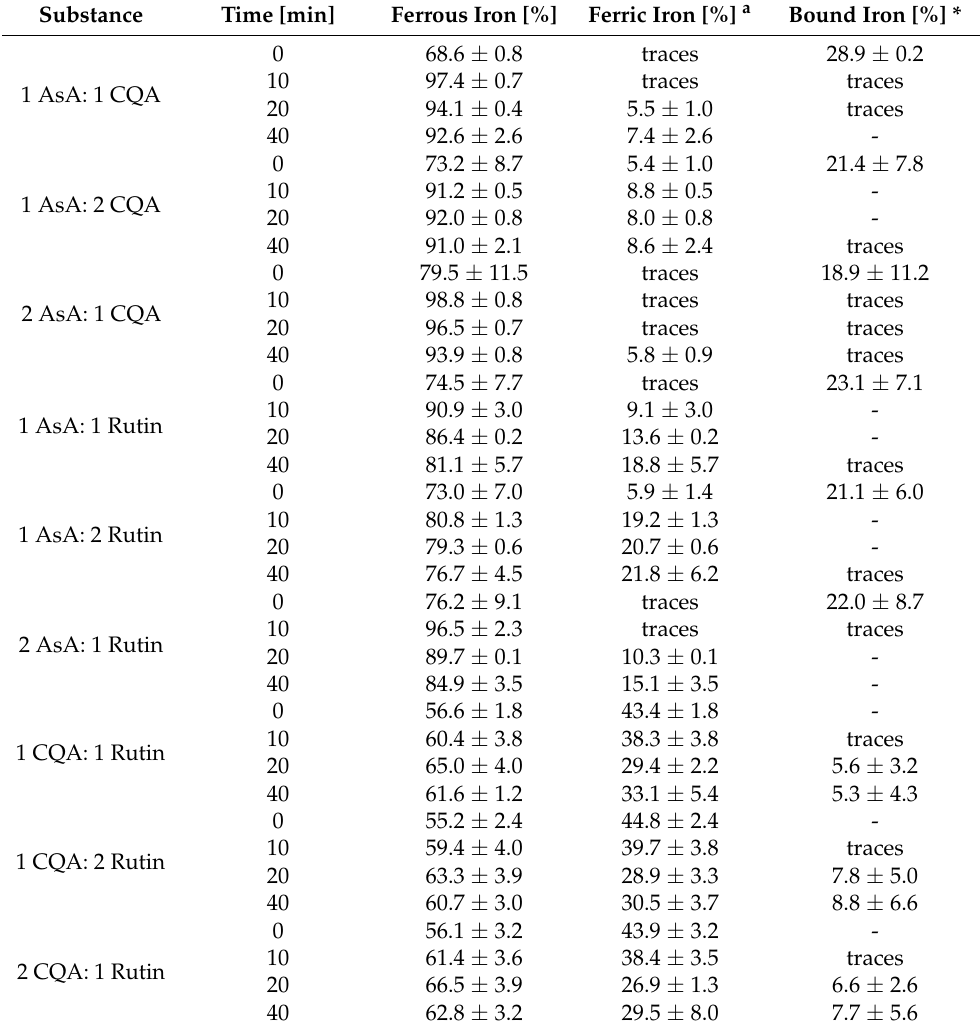
Table 2. Measured ionic iron species, ferric iron (Fe 3+ ) and ferrous iron (Fe 2+ ), and calculated bound iron after mixing with the double standard mixtures of ascorbic acid (AsA), 5-caffeoylquinic (CQA), and quercetin-3-rutinoside (Rutin), and cooking for 0, 10, 20, and 40 min with equimolar concentrations of ferrous and ferric iron in percent; traces ≤ 5%. Substance Time